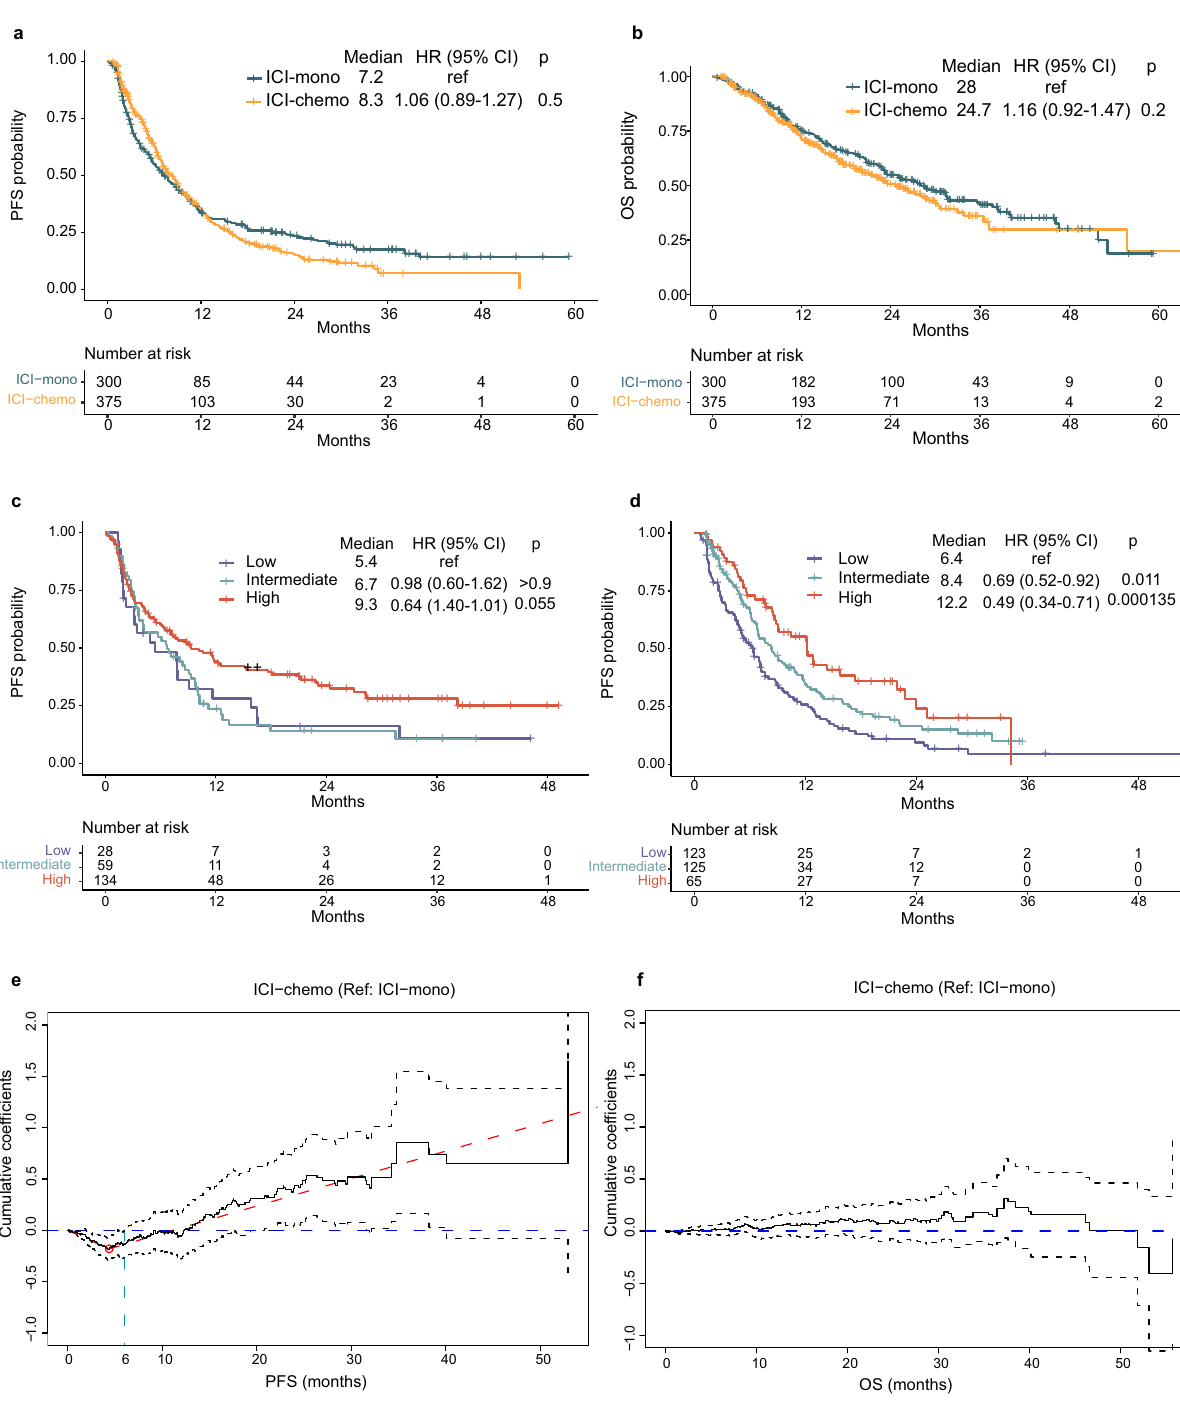
ratio (HR)and p valueswerecalculatedusing unadjusted coxproportionalhazards regressionmodels. e Aalen ’ sadditivehazardmodelonPFSand f onOS.Coef fi cient <0 favors ICI-chemo. Dashed gray lines indicate 95% con fi dence interval. Source data are provided as a Source Data fi